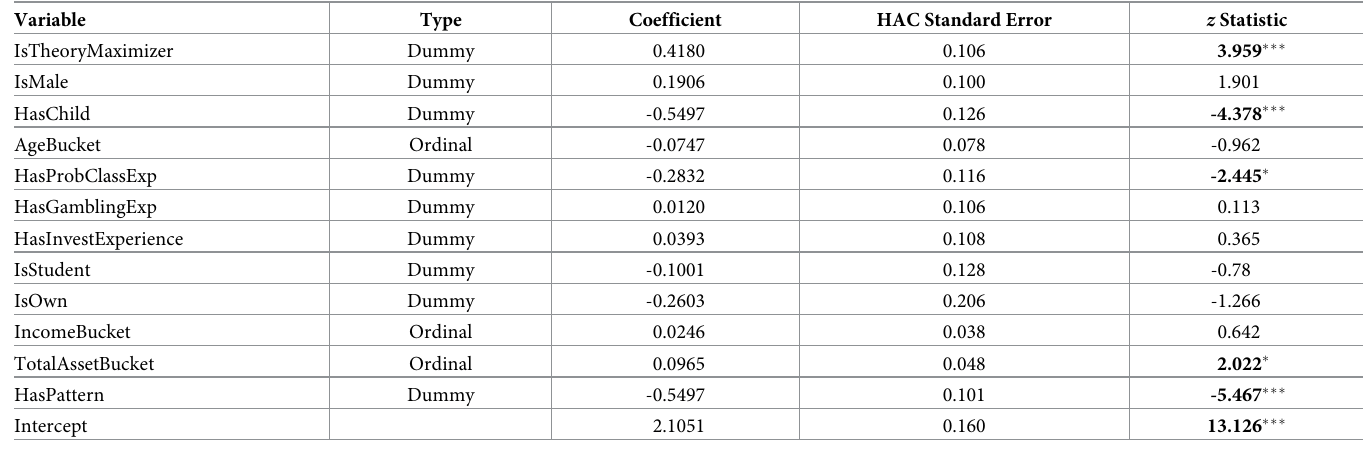
Table 3. Variables and coefficients for logistic